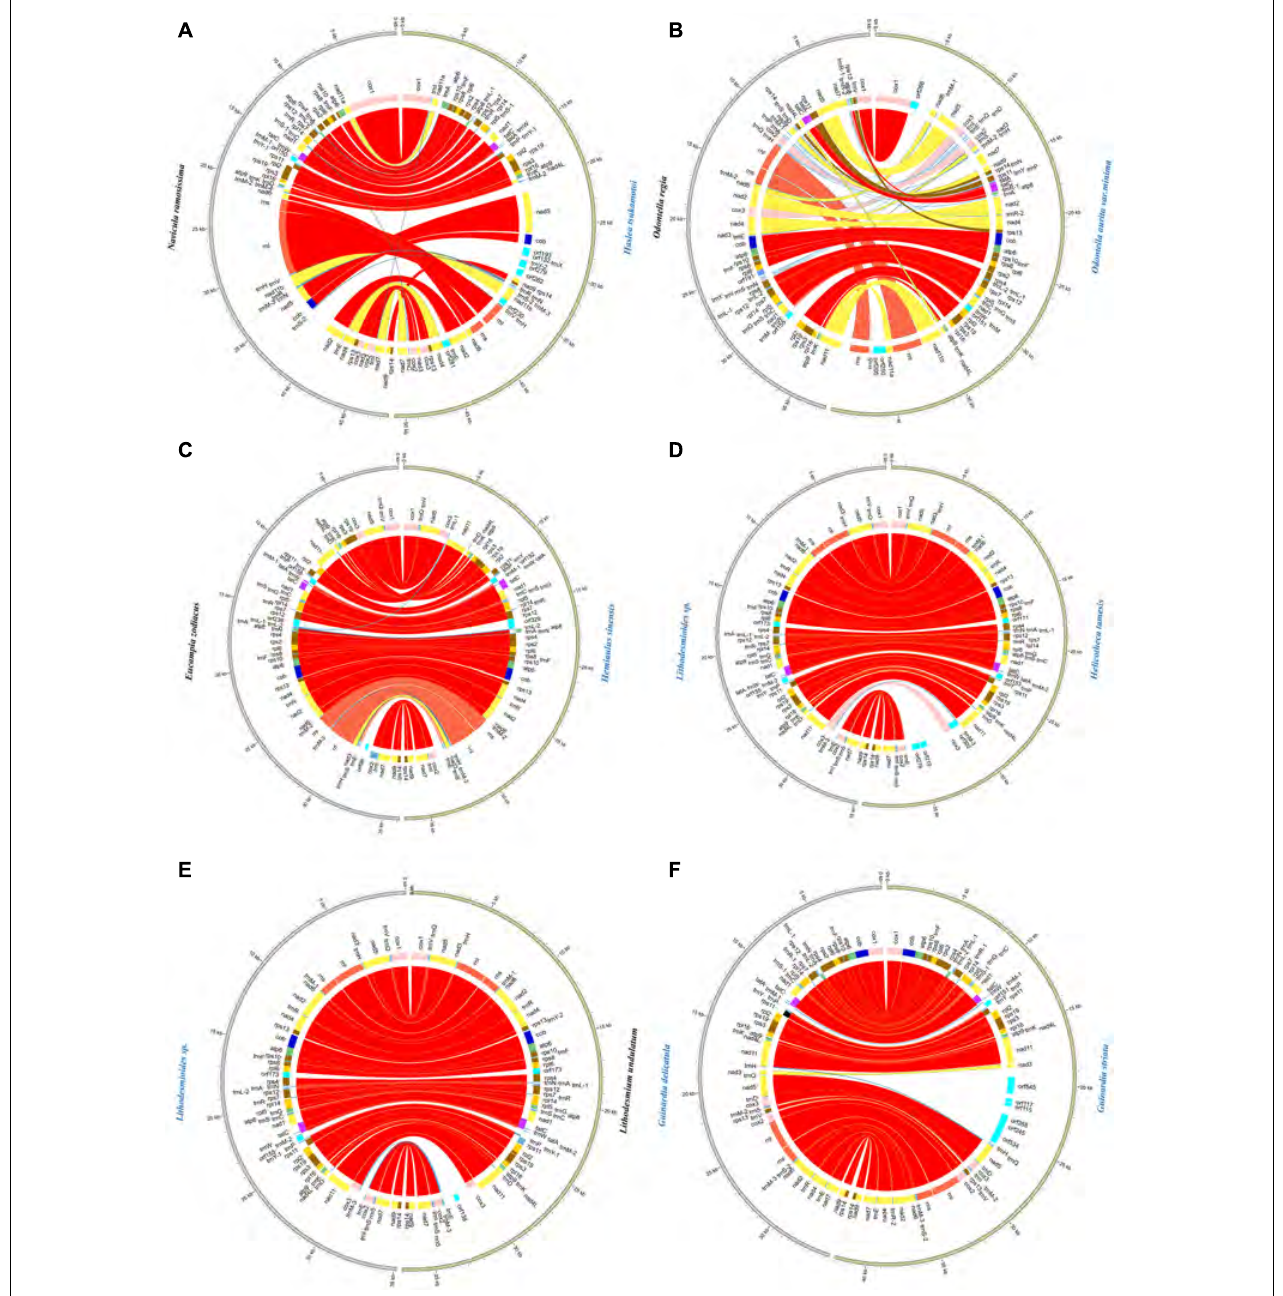
FIGURE 9 | Pair-wise comparison of representative mtDNAs. (A) The comparative analysis of Haslea tsukamotoi and Navicula ramosissima mtDNAs. (B) The comparative analysis of Odontella aurita var. minima and Odontella regia mtDNAs. (C) The comparative analysis of Hemiaulus sinensis and Eucampia zodiacus mtDNAs. (D) The comparative analysis of Helicotheca tamesis and Lithodesmioides sp. mtDNAs. (E) The comparative analysis of Lithodesmium undulatum and Lithodesmioides sp. mtDNAs. (F) The comparative analysis of Guinardia striata and Guinardia delicatula mtDNAs. The assignment of genes into different functional groups is indicated by colors. The conserved back-to-back arrangement of genes was all shown with same